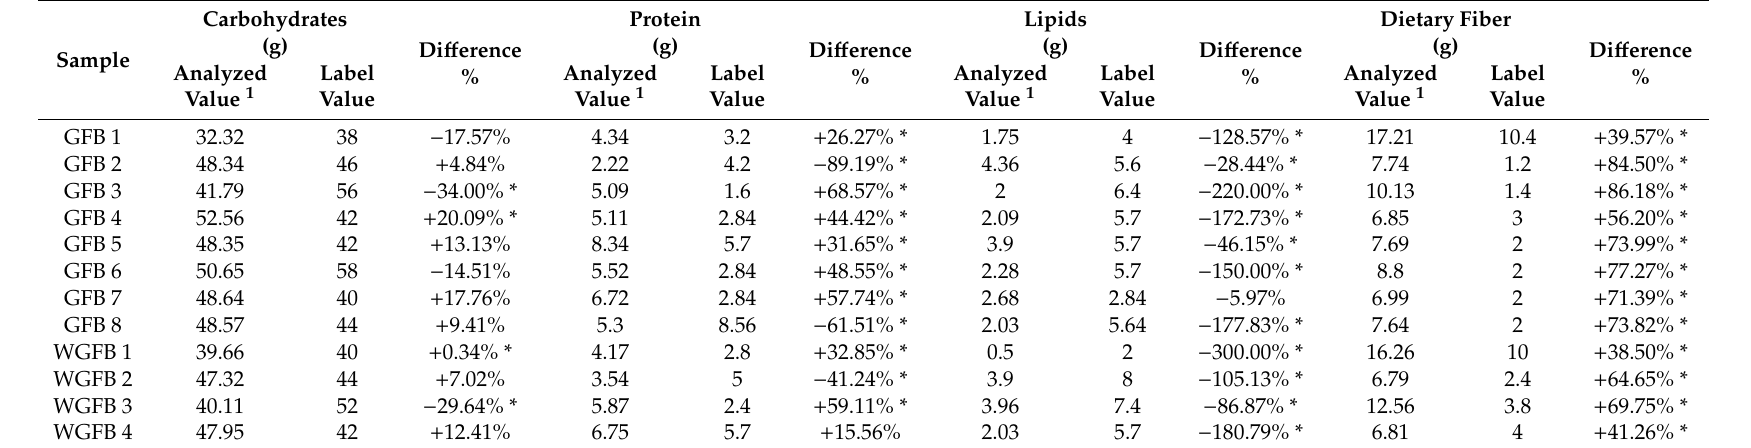
Table 3. Di ff erence percentages between mean values from chemical analysis and labels’ information of the samples (per 100